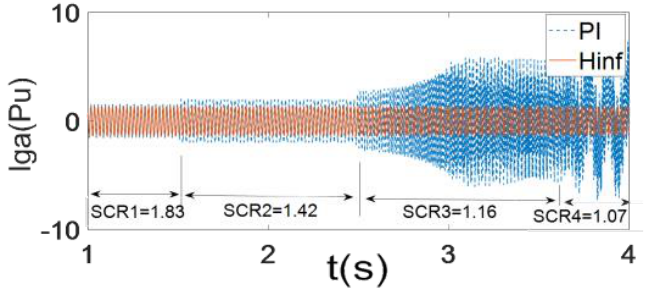
Figure 30. Current i ga at different SCR.